Question: Is the quantity shown trending increasing or decreasing?
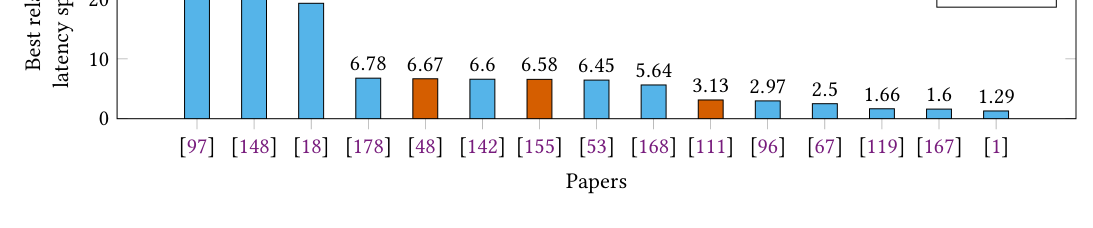
Answer: increasing